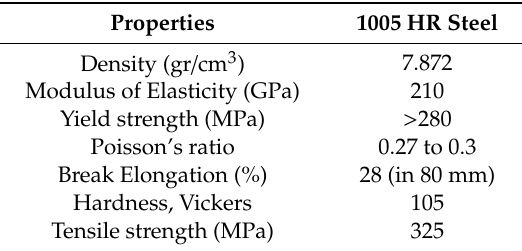
Table 1. Mechanical properties of 1005 HR Steel.